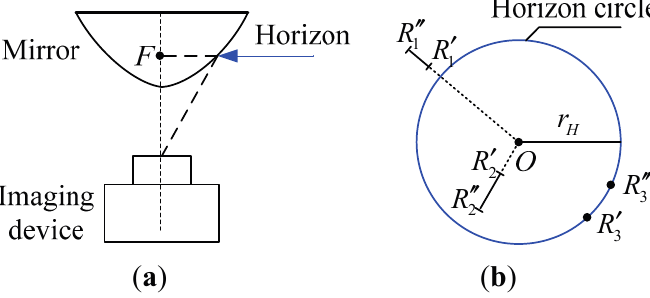
Figure 2. Distribution Constraint 1. ( a ) The formation of the horizon circle; ( b ) the distribution constraint of the landmarks based on the horizon